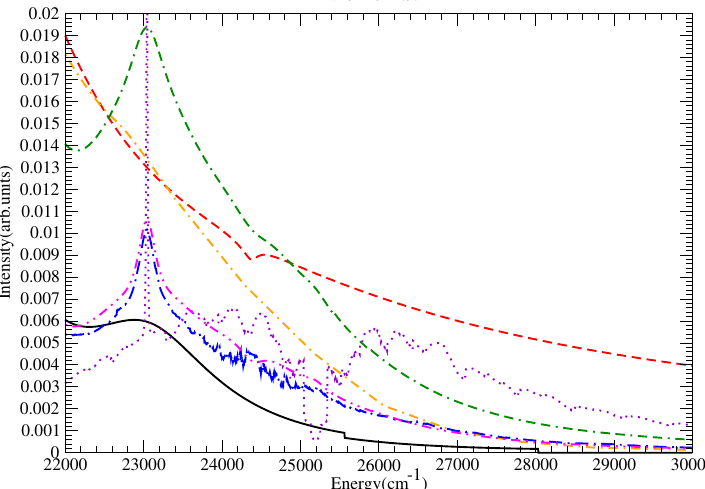
Figure 19. The region including and beyond H γ at the highest density. Shown are QC-FFM (solid), PPP (dashed), DWE (dash-dotted), CONVST without strong collisions (dotted), CONVST with strong collisions (dot-double dashed), CONVPST without strong collisions (long dash-dotted) and CONVPST with strong collisions (dash-double